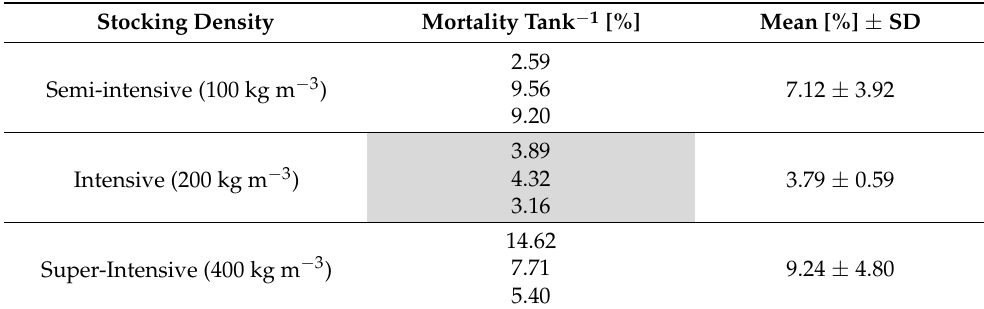
Table 4. Mortality in the three treatment groups with semi-intensive, intensive, and super-intensive stocking densities ( p >